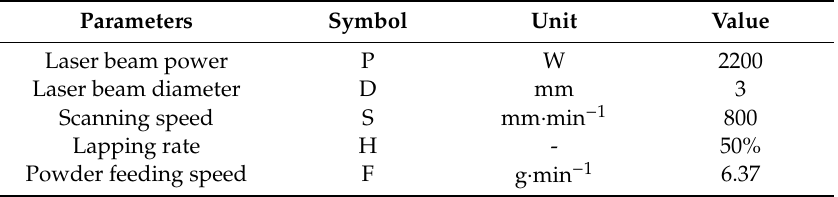
Table 1. Laser melting deposition parameters used in this